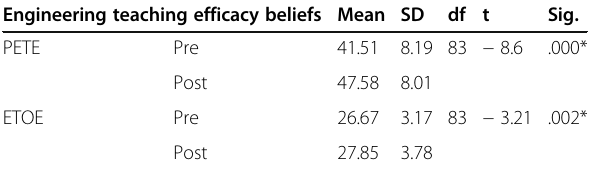
Table 2 Means, standard deviations, and paired sample